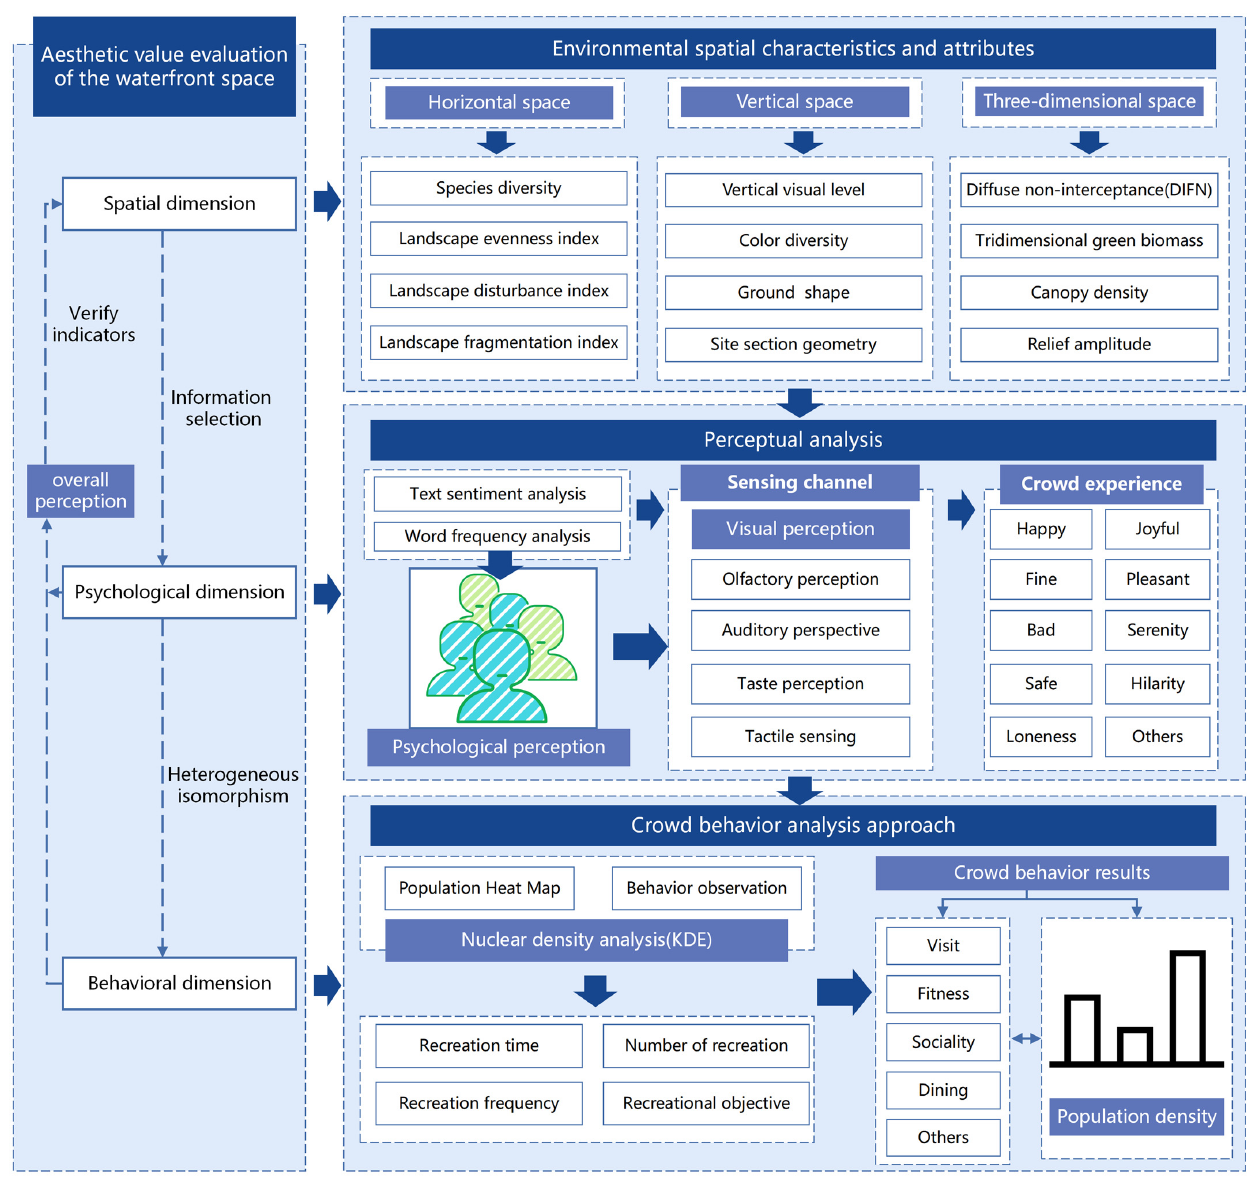
Figure 3. Space–psychology–behavior dimension landscape aesthetic evaluation mechanism.